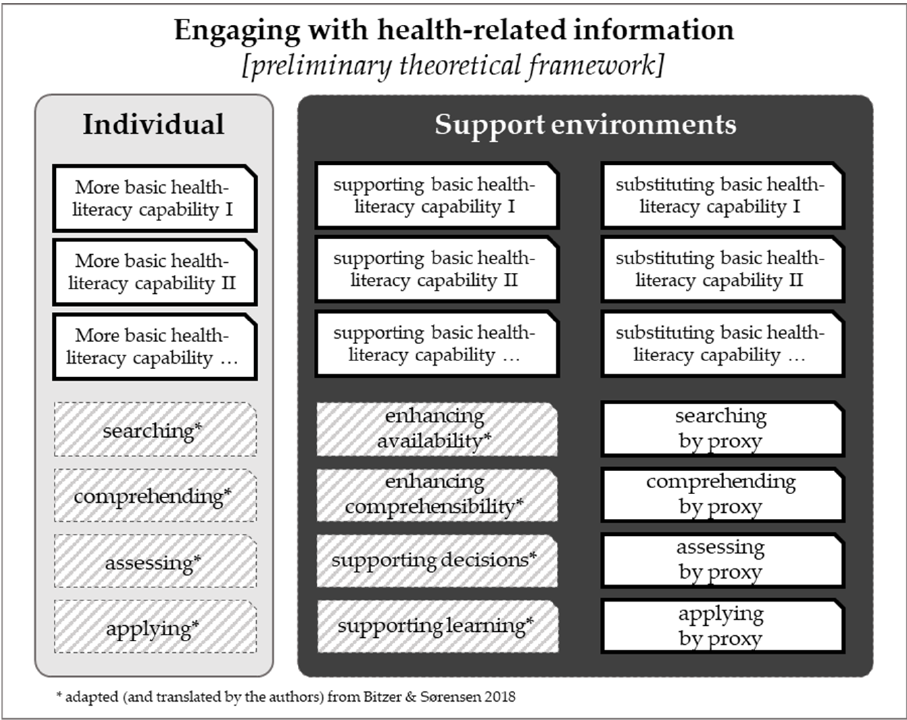
Figure A1. Preliminary theoretical framework resulting from the analysis of Delphi-1. Table A2. Questionnaire of the online survey (time frame for completion: 24 January until 3 April 2022).